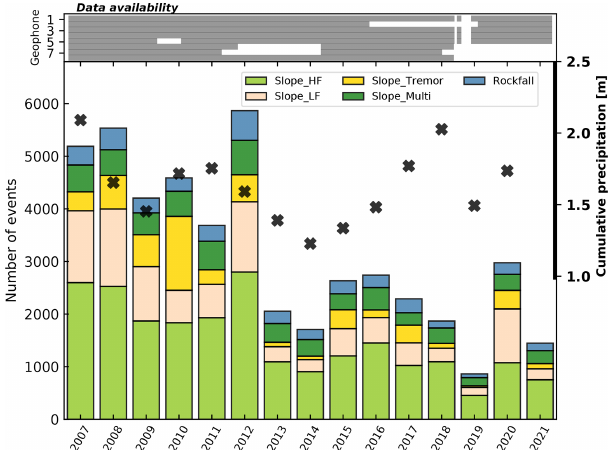
Figure 10. Distribution of slope-related microseismic events over 15 years. Left axis: number of events. Right axis: cumulative pre- cipitation for each year (black crosses). Note that the rain gauge malfunctioned in 2021; hence the value was removed. Top: data availability for each geophone (1 at the top to 8 at the bottom). Grey colour: available data; white: missing data.